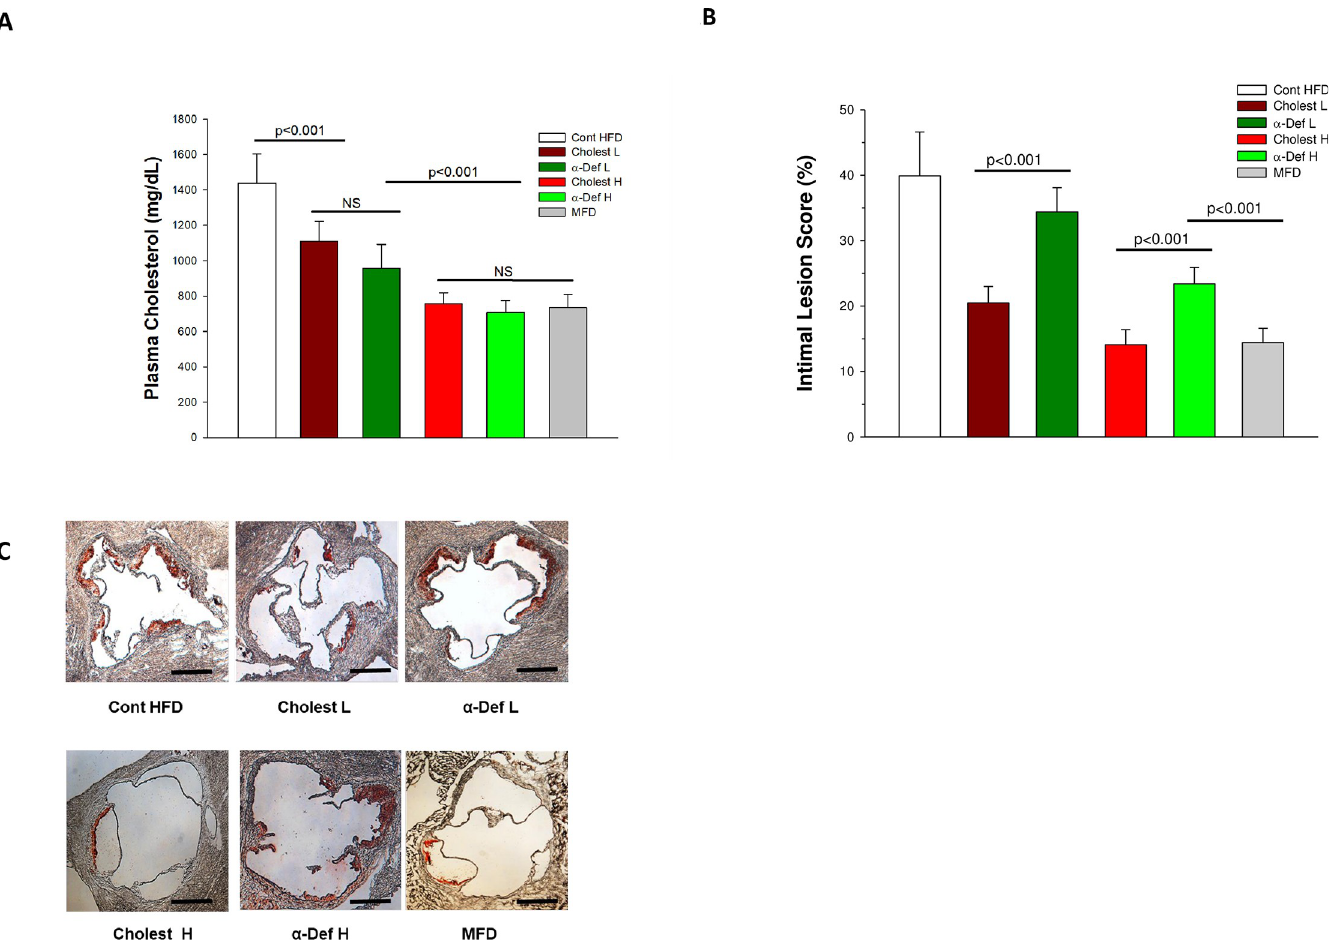
Fig 1. Effect of intervention on plasma cholesterol and development of lipid streaks in aortic roots. Panel A. Cholesterol levels . ApoE − / − mice fed a HFD for 6 weeks were divided into 5 groups (n = 16/group). One went untreated (Cont). Two groups were given two oral doses of either a low or high dose cholestyramine, 1.5% (Choles L) or 3% (Choles H), respectively. Two groups were given two IV injections of α -def-1, 10 or 30 μ g, every other day ( α -def-1 L) and ( α -def-1 H) respectively. A sixth group was given a modified high fat diet (MFD) for 6 weeks. Blood samples were taken after 6 hours of fasting. Plasma levels of total cholesterol (TCH) were measured. Panel B. Development of lipid streaks. ApoE − / − mice on HFD or MFD for 6 weeks described in Panel A were sacrificed after blood draw. Lesion size in sections from the aortic roots (See Panel C) was measured as described in the Methods section. Results are expressed as the percent of the aortic root circumferences stained by Oil Red O. The mean ± S.D. and p < 0.05 values are shown; n = 16 per group. Panel C. Lipid streaks. Representative sections from the various experimental groups are shown. Scale bars represent 500 μ m.